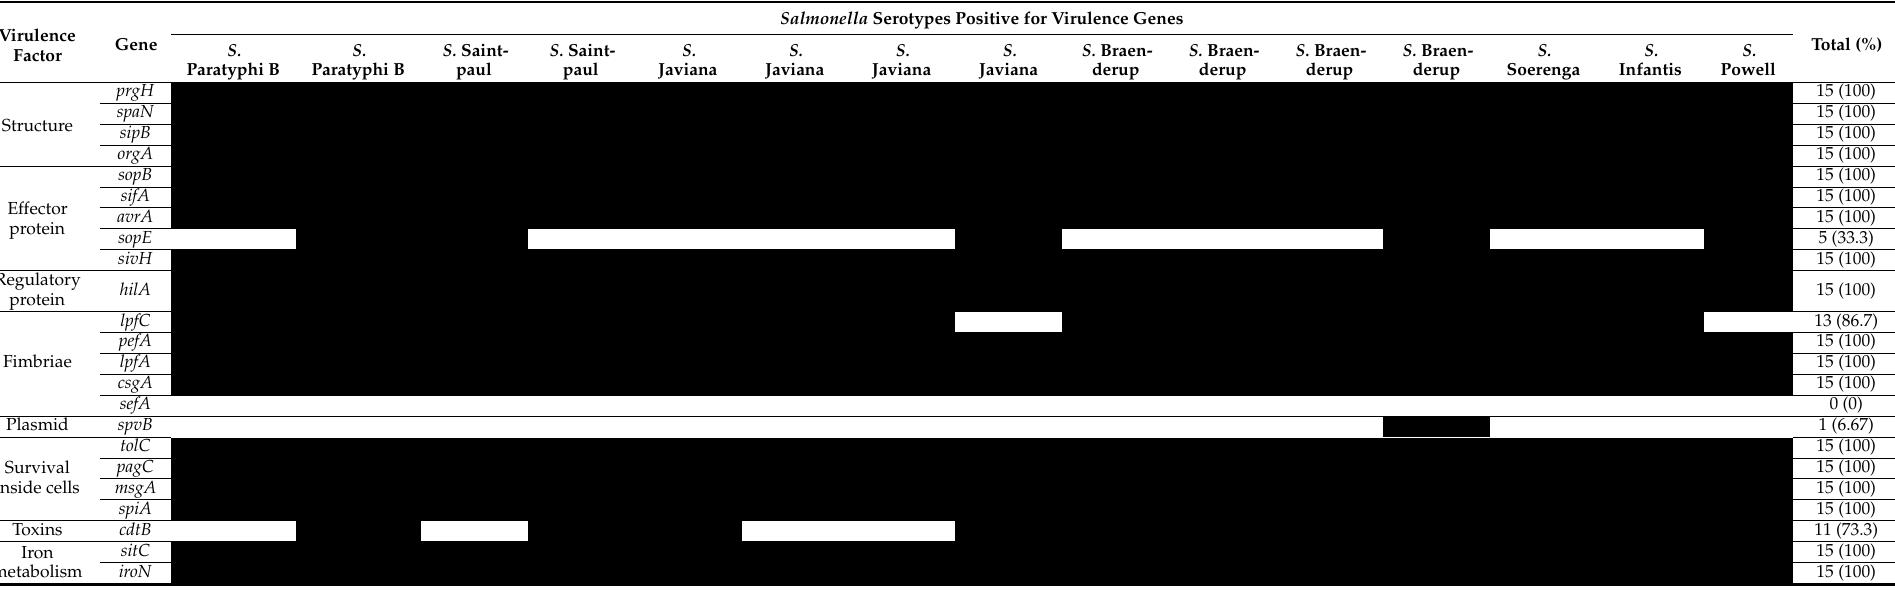
Table 3. Virulence genes profiles of Salmonella spp.